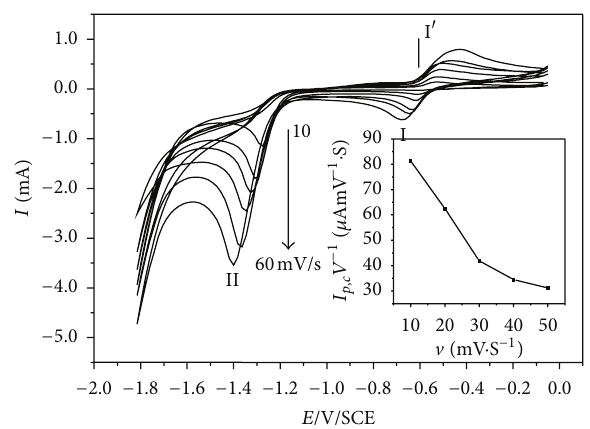
Figure 4: Effect of the scan rate on the cyclic voltammograms recorded with a thinfilm electrode in contact with an aqueous medium at pH = 1. The scan rate was V = 10 to 60mV ⋅ s −1 . The inset shows the variation of the ratio 𝐼 𝑝,𝑐 / V on the scan rate for the peaks